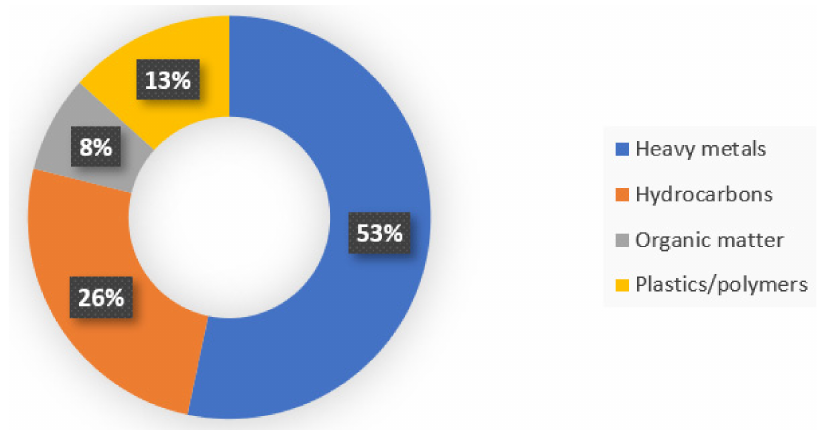
Figure 5. Types of pollutants studied for biological soil